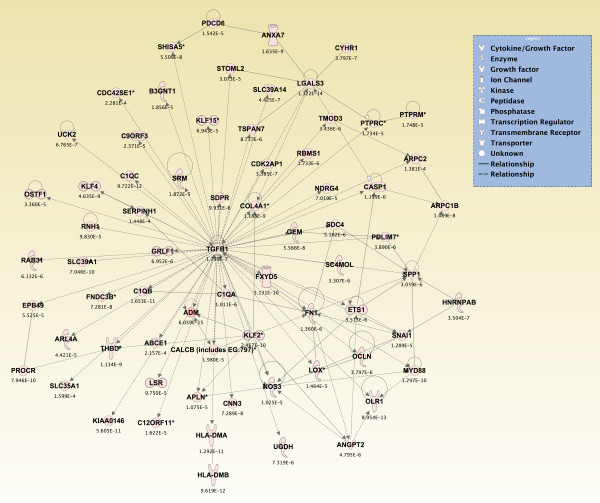
Seizure-induced alteration of cell-to-cell signalling/interaction, hematological system development/function, and immune cell trafficking gene network.